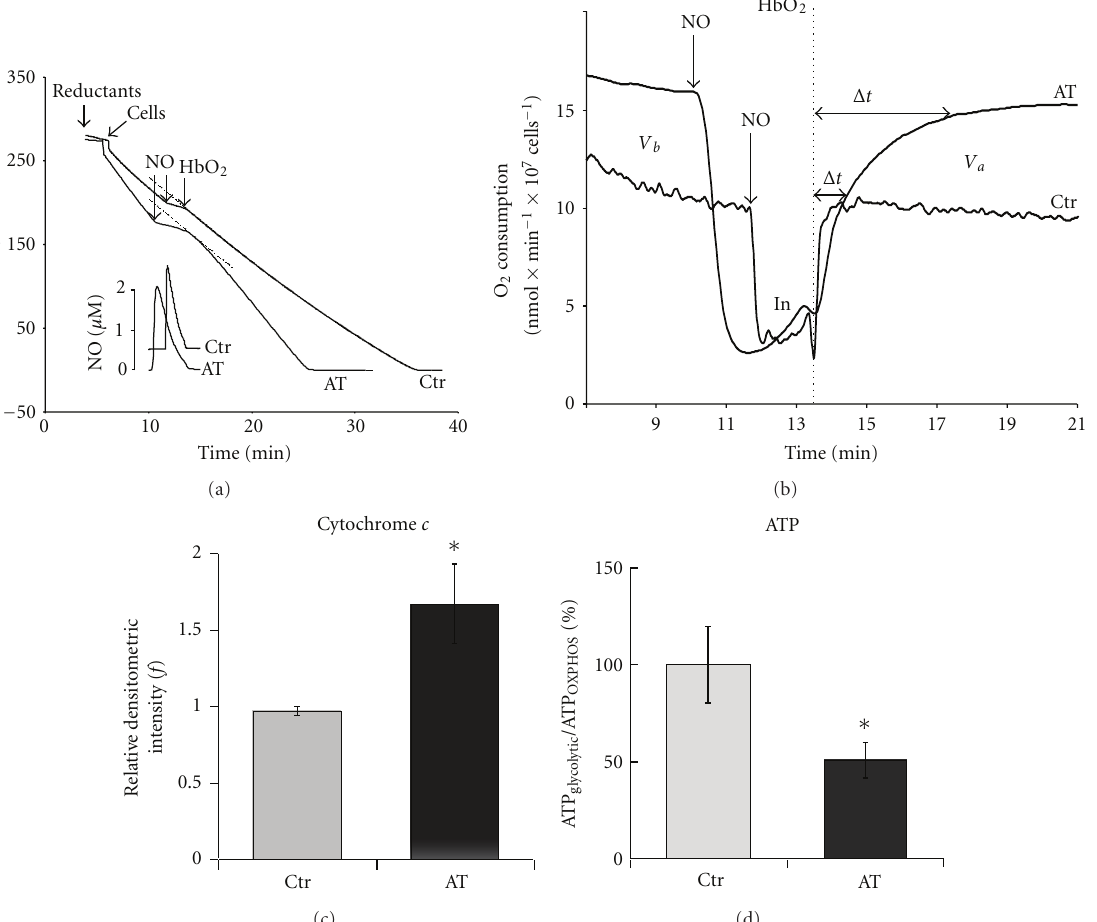
Figure 4: Oxygen consumption of Ataxia Telangiectasia (AT) cells: the inhibitory e ff ect of NO. (a)—O 2 consumption profiles of AT and control lymphoblastoid cells, recorded in the dark and in the presence of excess ascorbate and tetramethyl-p-phenylenediamine (TMPD). Inhibition of respiration was induced by adding a single bolus of pure NO gas solution (see lower NO profiles). In order to assess the fraction of residual inhibited CcOX-NO, the instantaneous rate was measured at 45 s after HbO 2 addition. (b)—First derivative plots (integration time t = 2s). Rate of O 2 consumption before addition of NO ( V b ), and after addition of oxygenated hemoglobin, HbO 2 ( V a ), that is, in the absence of free NO. In : inhibited state (in the presence of free NO). The Δ t value is the time necessary for complete recovery of activity after addition of HbO 2 . T = 25C. (c)—Cytochrome c immunoblot. Cell-lysate (30 μ g/well) of AT patients and controls (ctr). (d)—Relative contribution of OXPHOS and glycolysis to ATP production in AT and control cells. Modified from